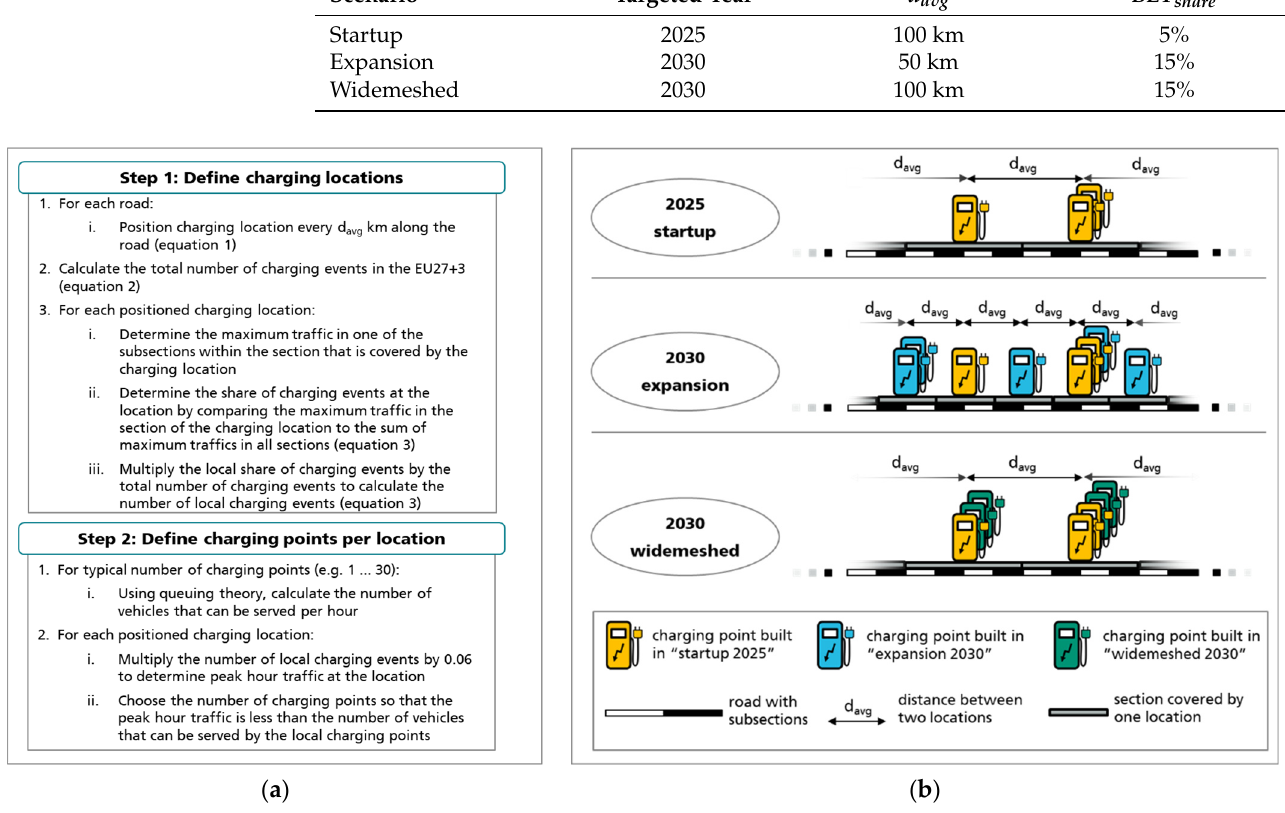
Figure 2. Methodological procedure ( a ) and simplified draft ( b ) for the calculation of the charging networks.